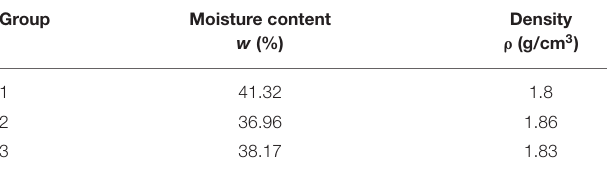
TABLE 2 | Test results of physical properties of remolded samples. Group